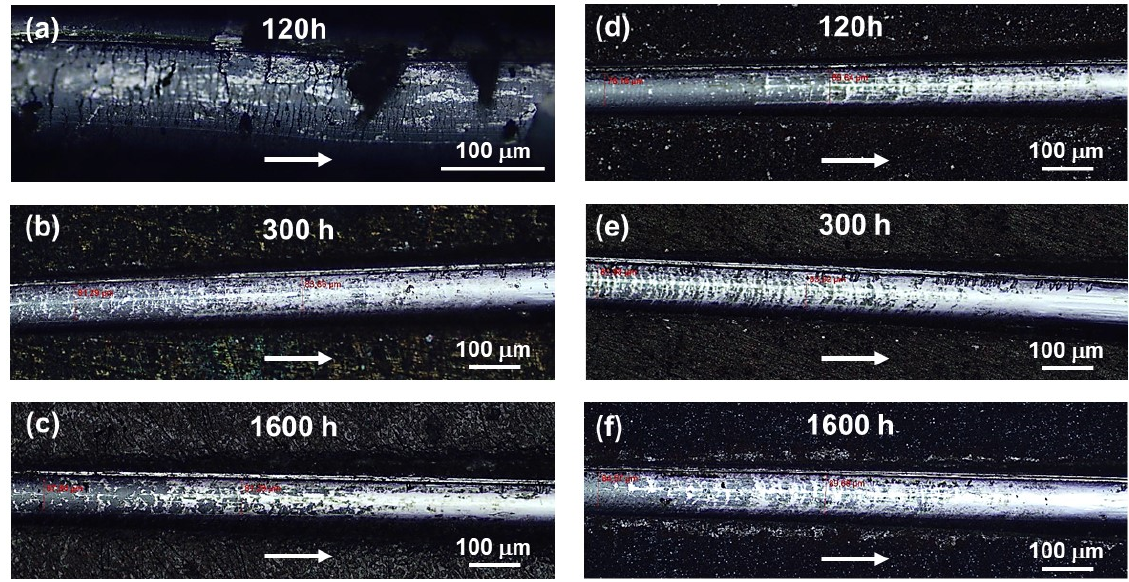
Figure 9. Optical microscopy images at the same intermediate region of scratch tracks on the oxide scale surface of: ( a ) AISI1020, ( b , c ) DS2507, and ( d – f ) DS2205, after several exposure times indicated in each image. The white arrow indicates the indenter sliding direction during the scratch test.